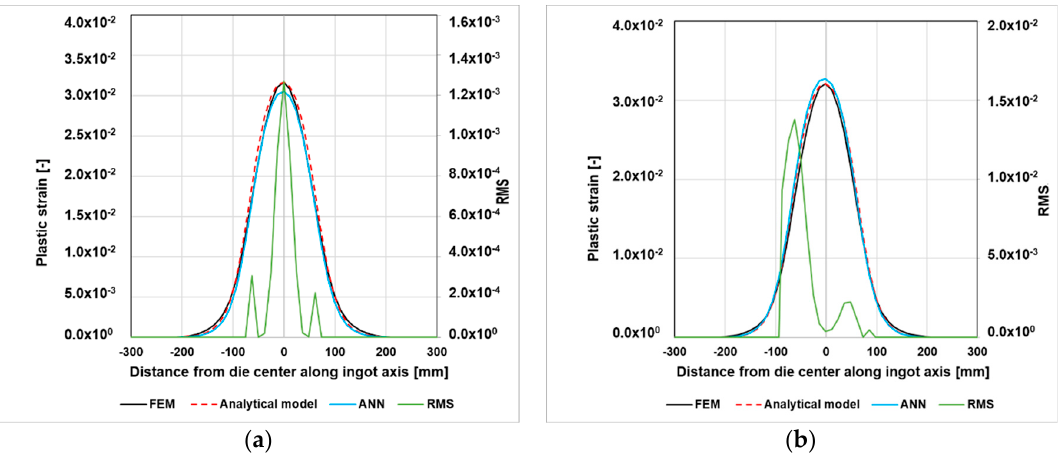
Figure 9. Total equivalent plastic strain as a function of length for Sb 0 = 150 mm, reduction of 5%, first stroke at ( a ) 800 °C, ( b ) 1200 °C.